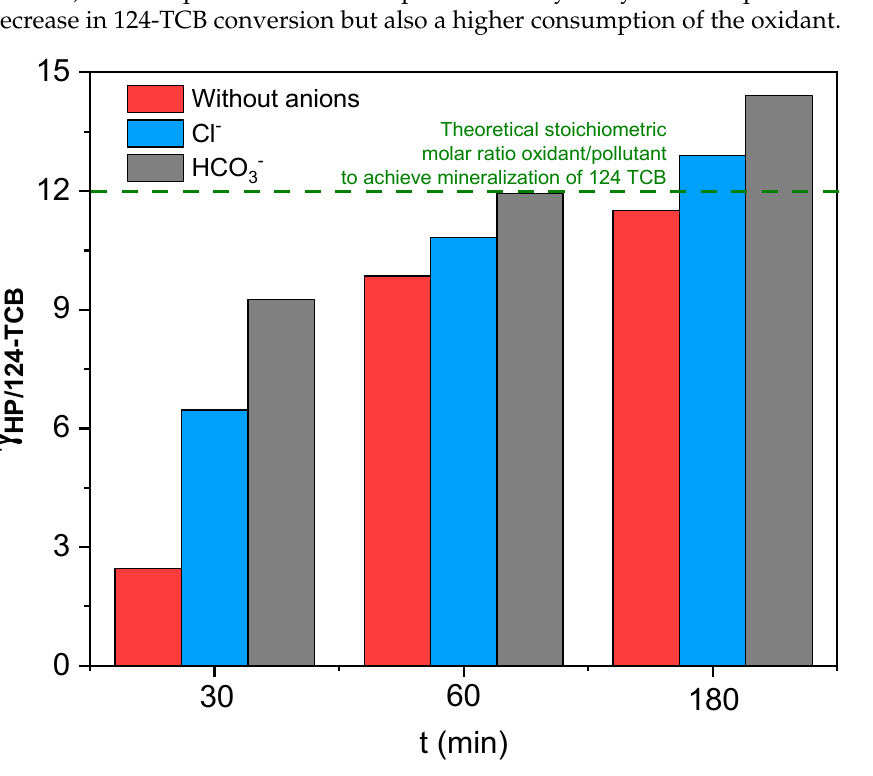
Figure 6. Specific consumption of the oxidizing agent with time in the absence and presence of anions. Experimental conditions: Fe = 7.10 mg L − 1 , H 2 O 2 = 290 mg L − 1 , 124-TCB = 28 mg L − 1 , Cl − = 600 mg L − 1 , HCO 3 − = 600 mg L − 1 , and High rad intensity. (- - -) corresponds to the theoretical stoichiometric molar ratio oxidant/pollutant to achieve mineralization of 124-TCB (Equation (1)). For short reaction times (30 and 60 min), the consumption of oxidizing agents associated with the decomposition of 124-TCB is below the stoichiometric value for mineralization of 124- TCB (12, as shown in Equation (1)), meaning that intermediate organic compounds are gener- = 11.55 mol HP mol − 1 124 − TCB ) was ated. At 180 min of reaction, this value ( γ t = 180 min HP /124 − TCB close to the stoichiometric one, probably associated with the oxidation of these intermediate com- = 14.45 mol HP mol − 1 124 − TCB ) pounds. The maximum oxidant consumption ( γ t = 180 min HP /124 − TCB was found for the HCO − system (t = 180 min). This value implies an additional consump- 3 tion of 2.90 mol of HP per mol of contaminant removed, compared to the γ t = 180 min HP /124 − TCB obtained in the absence of anions. This additional consumption is associated with the inhibitory effect of inorganic species in real groundwater. Values of γ t for runs HP /124 − TCB in Table 1 are also included in Table